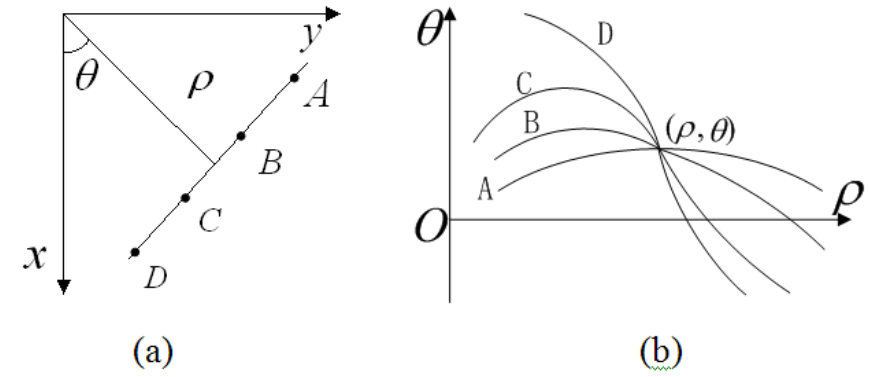
Figure 9. HT representation ( a ) cartesian coordinate; ( b ) parameter